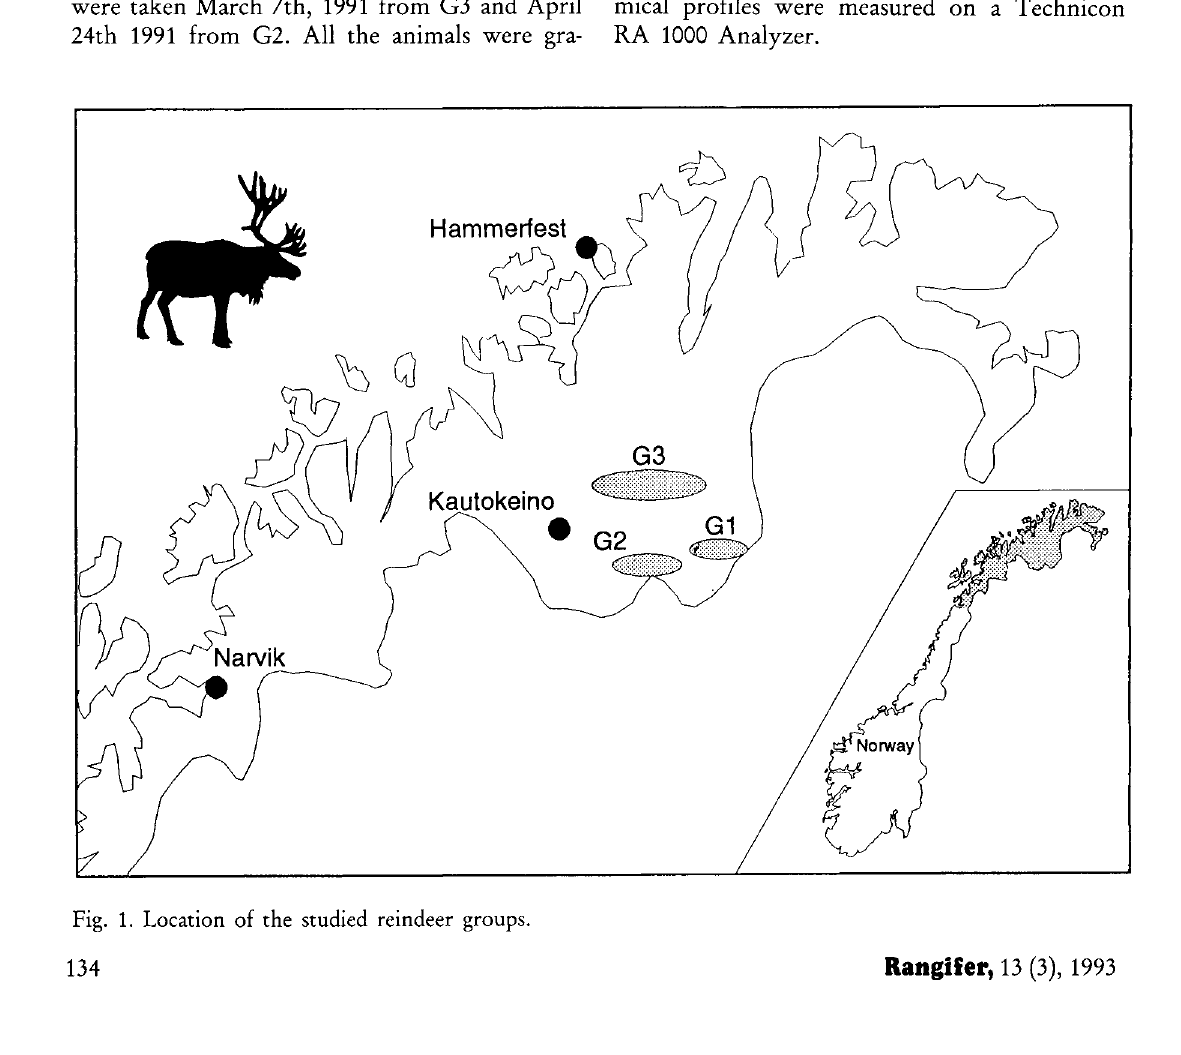
Fig. 1. Location of the studied reindeer